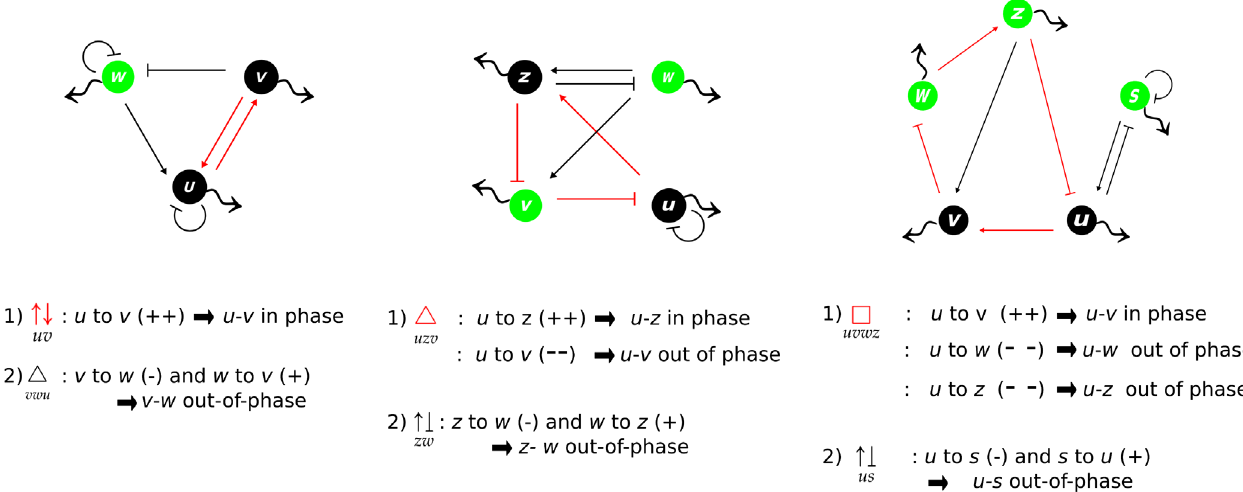
FIG. 15. Examples of the application of the method to establish the phases of the Turing pattern without calculation of the eigenvectors. The positive cycle of the destabilizing module is set in red. Nodes in phase are filled with the same